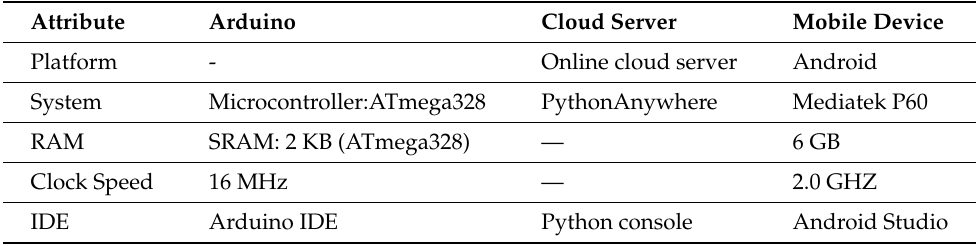
Table 3. Specifications of devices.